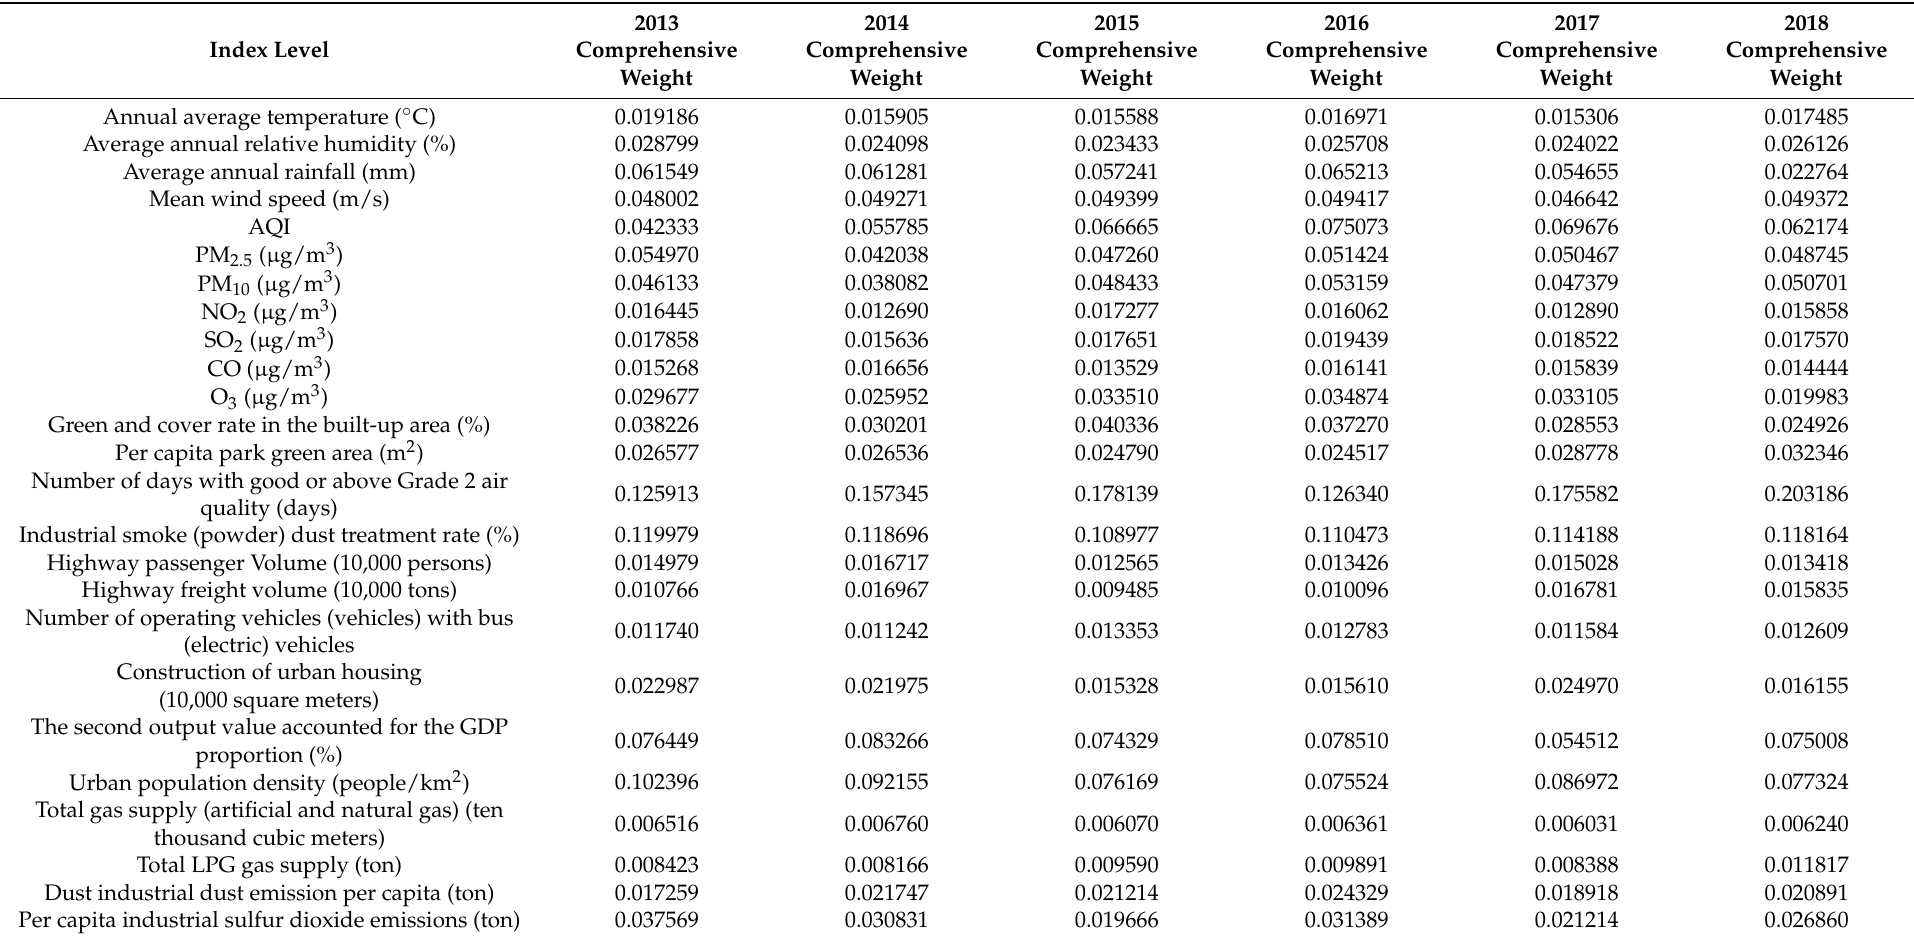
Table 4. Weight of comprehensive